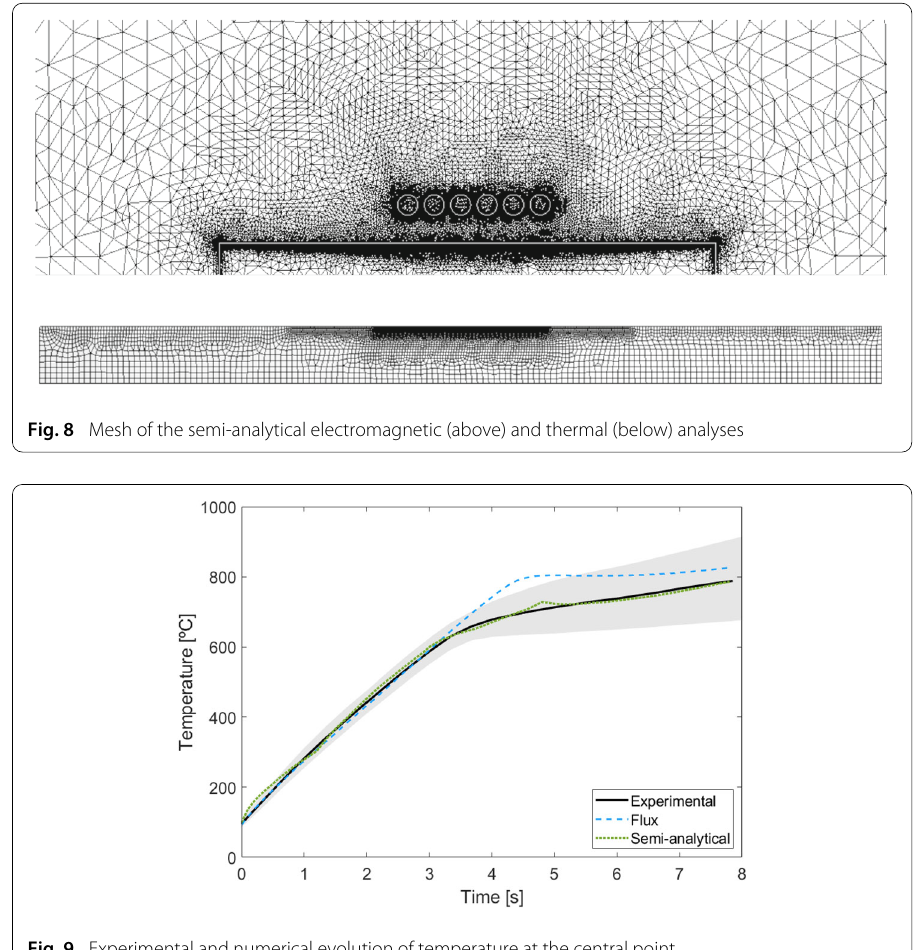
Fig. 9 Experimental and numerical evolution of temperature at the central